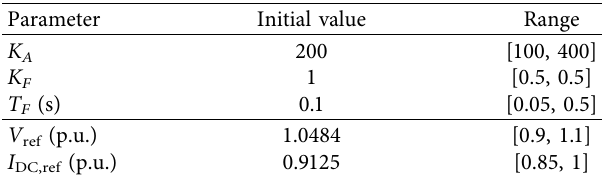
Table 6: Efect analysis of optimization to I